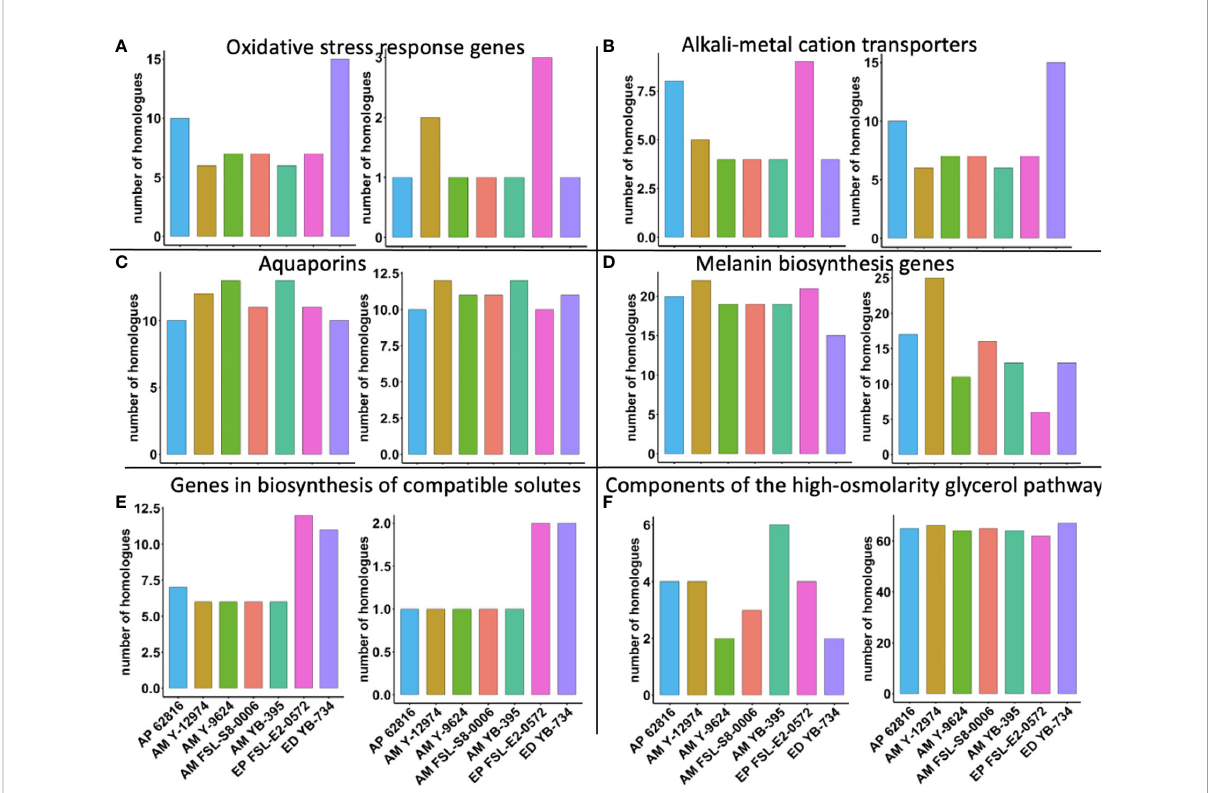
FIGURE 6 Number of gene homologues in food-relevant black yeast (per haploid genome). (A) Oxidative stress response genes: catalase (left) and copper, zinc superoxide dismutase (right); (B) Alkali-metal cation transporters: potassium transport protein (left) and cation ef fl ux system proteins (right); (C) Aquaporins: aquaglyceroporin (left) and aquaporin (right); (D) Melanin biosynthesis genes: laccase (left) and polyketide synthase (right); (E) Genes in biosynthesis of compatible solutes: a , a -trehalose-phosphate synthase (left) and NAD-dependent glycerol-3- phosphate dehydrogenase (right); (F) Components of the high-osmolarity glycerol pathway: high osmolarity signaling protein (left) and mitogen-activated protein kinase